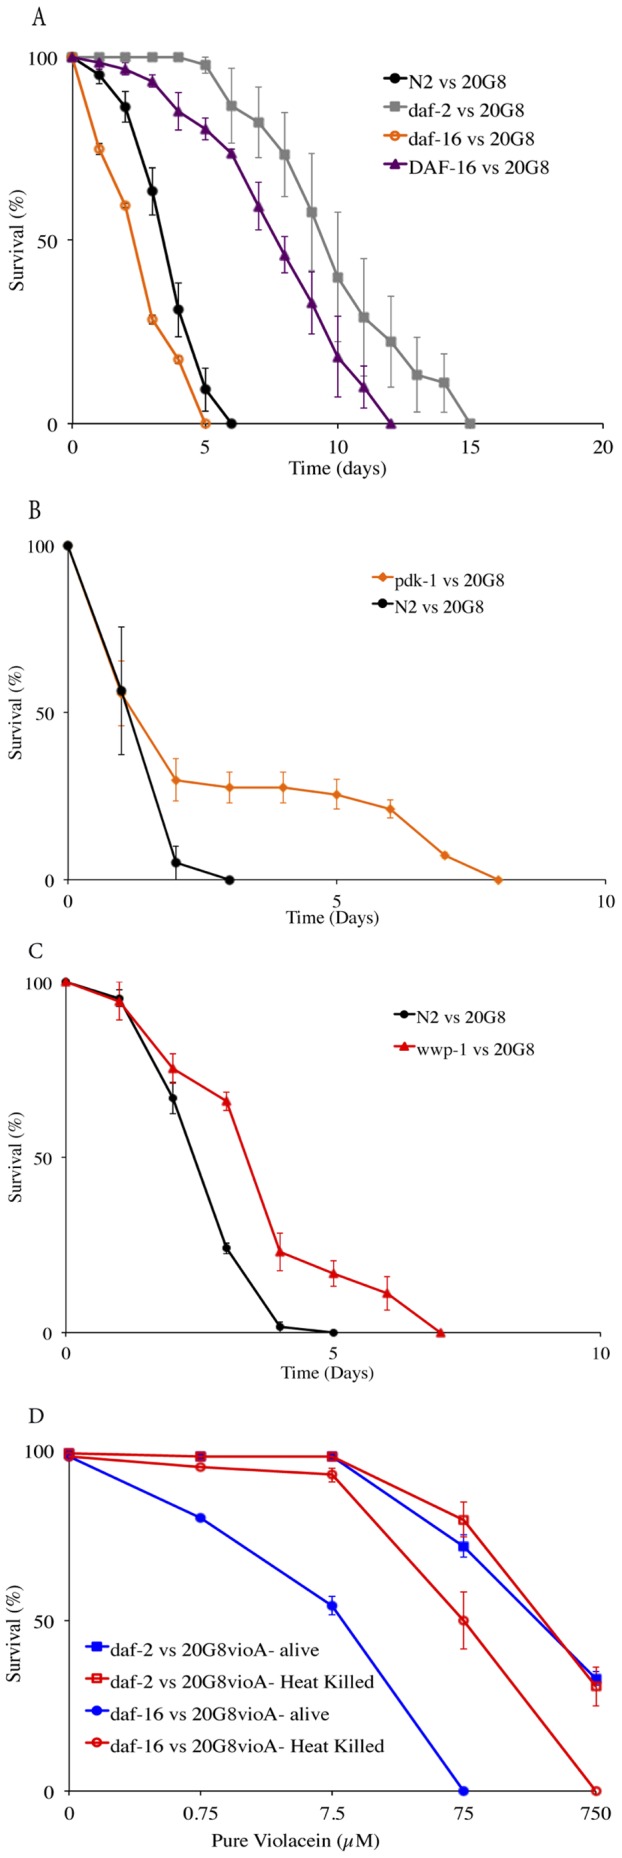
Nematode killing assay and dose response assay (wild type animals and daf-2, daf-16, pdk-1, wwp-1 and DAF-16 mutant nematodes vs 20G8 clone).The survival of nematodes fed with 20G8 clone was measured for (A) daf-2, daf-16 and DAF-16 mutant animals. (B) pdk-1 mutant animals (C) wwp-1 mutant animals (D) Dose response of C. elegans daf-2 and daf-16 strains to pure violacein added to 20G8vioA− mutant bacteria alive and heat killed. Each data point represents means ± the standard error of three replicate plates p values were calculated on the pooled data of all of the plates in each experiment by using a Students t-test on the number of surviving nematodes at day seven.